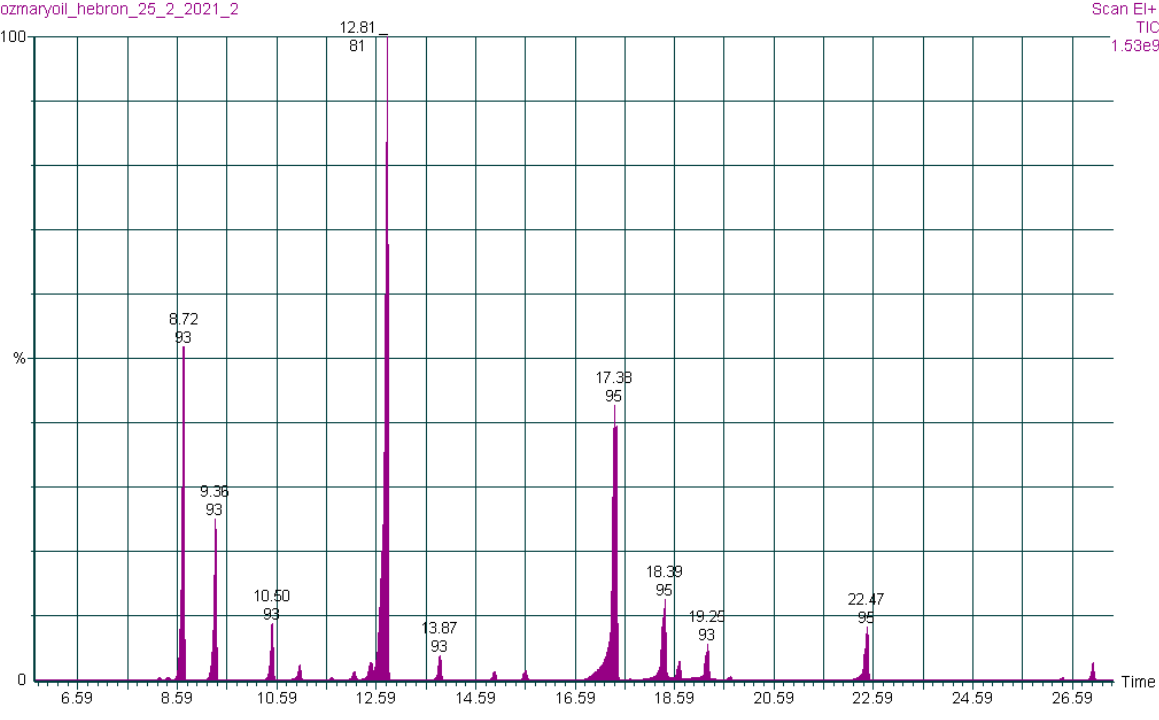
Figure 2. Gas chromatography chromatogram of R. officinalis Leaves essential oil collected in Heb- ron.